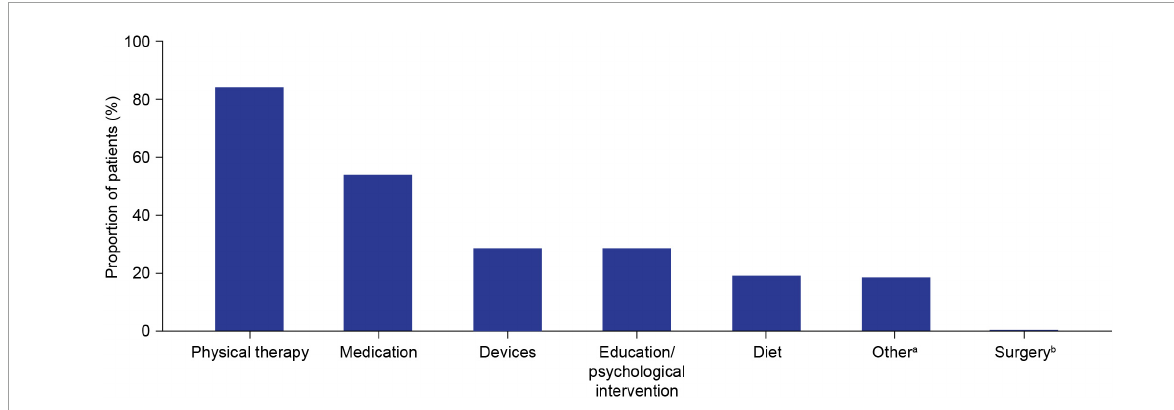
FIGURE4 Initial patient management plan components. Multiple components could be selected for each patient. a Other initial management plan components included the following categories, which group together free-text responses for initial management plans that were not covered by the six predefined options: cardiac evaluation/follow-up/management ( n = 26); bone health management ( n = 19); genetic counseling/carrier testing ( n = 3); occupational therapy ( n = 2); speech therapy ( n = 2); neurological referral/management ( n = 3); orthopedic referral ( n = 1); referral to general practitioner ( n = 1). b Spine surgery/thoracic lumbar